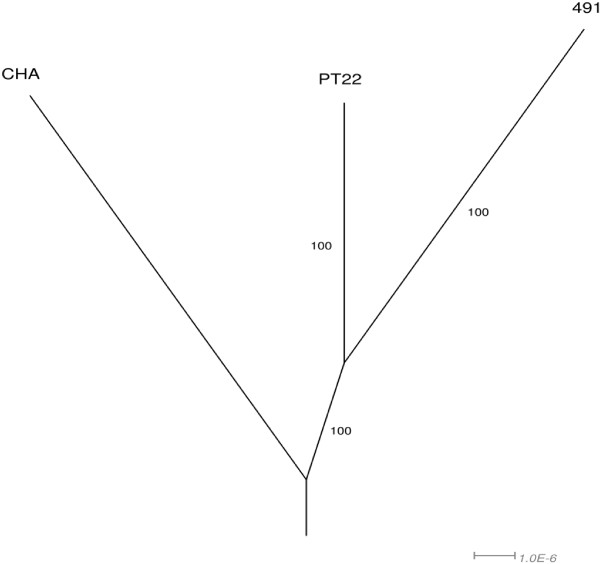
Phylogenetic network for clone CHA isolates based on identified SNPs. All SNPs mentioned in Figure 1 were incorporated into three pseudosequences derived from the PAO1 reference sequence by the script SequenceReplacer (available on request from the authors). The network was produced using the uncorrected P distance measure with normalisation followed by the NeighbourNet algorithm in the program Splitstree [62]. The scale indicates the number of substitutions per site. Numbers on the branches are 100 bootstrap resampling values which give a measure of the confidence of the displayed tree topology. A network for clone TB is not shown as the isolates display up to two orders of magnitude less divergence than clone CHA strains, which cannot be visualised appropriately.